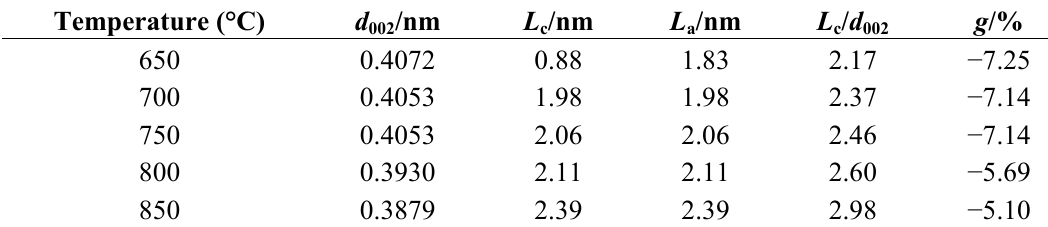
Table 1. Structure parameters of XRD for